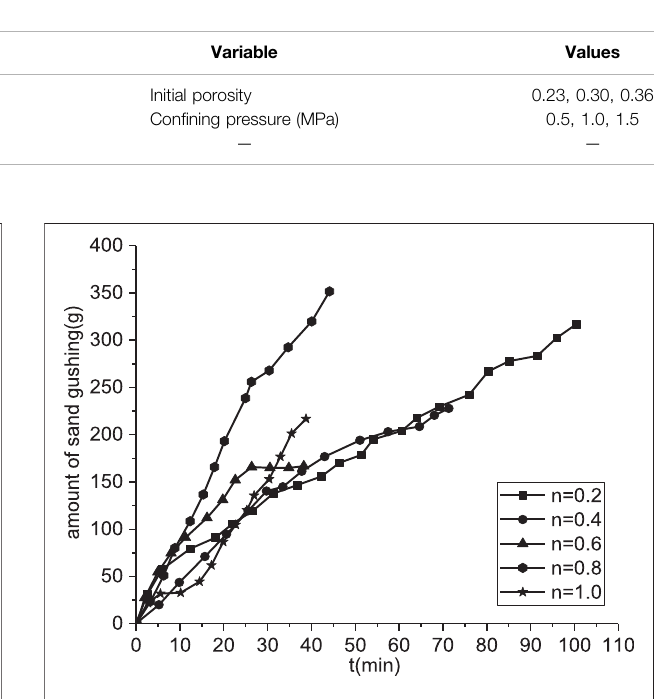
FIGURE 4 | Time-varying curve of sand gushing with different particle size